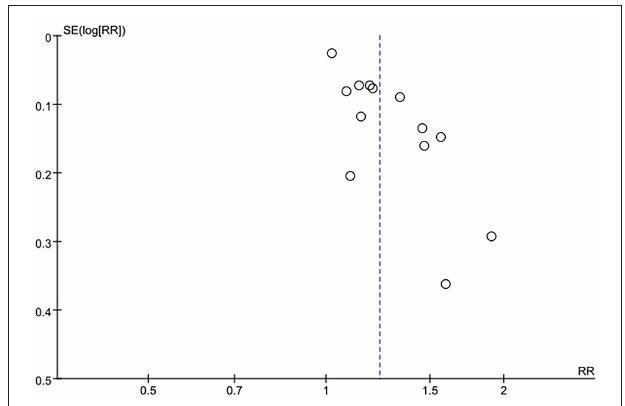
FIGURE 9 | A Funnel plot of the current smoking and the former smoking